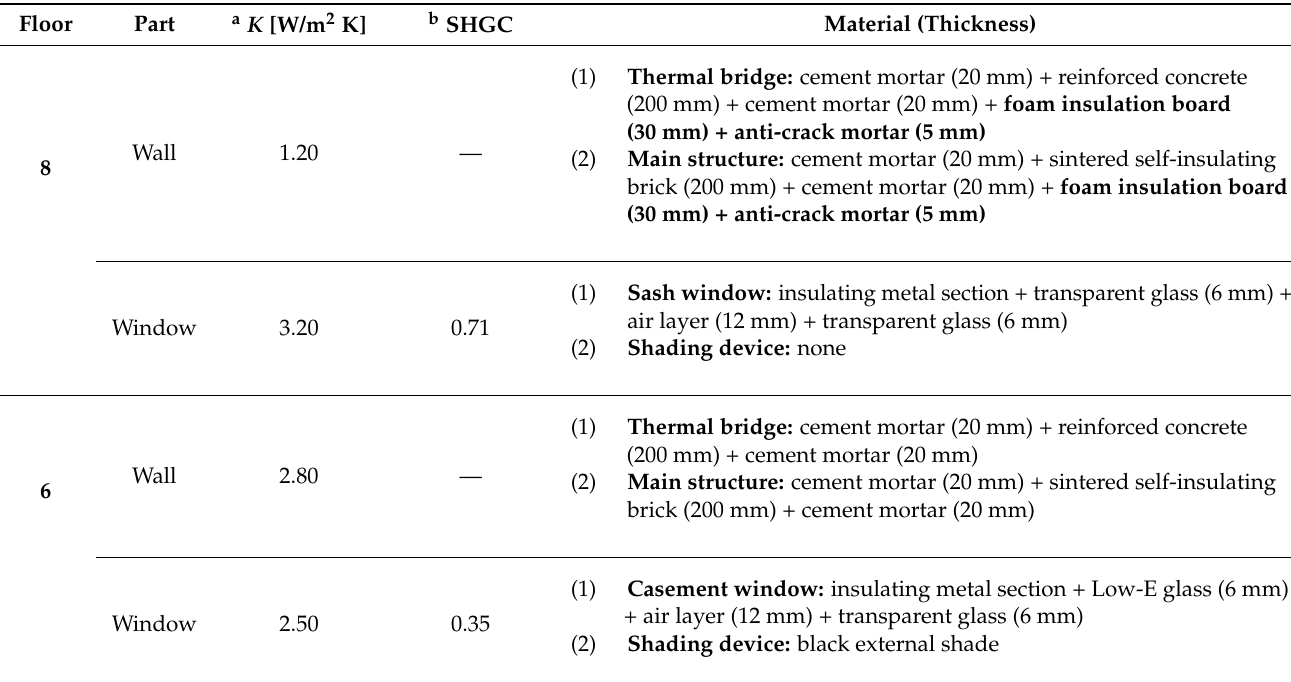
Table 3. Materials and thermal parameters of building envelope of the sixth and eighth